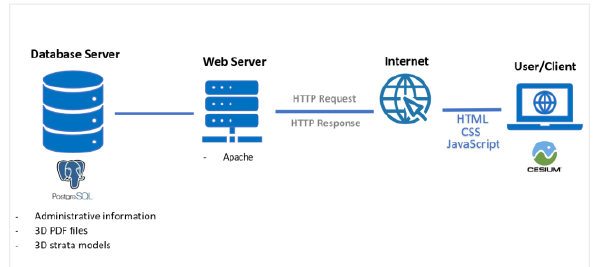
Figure 5. The proposed architecture for design and